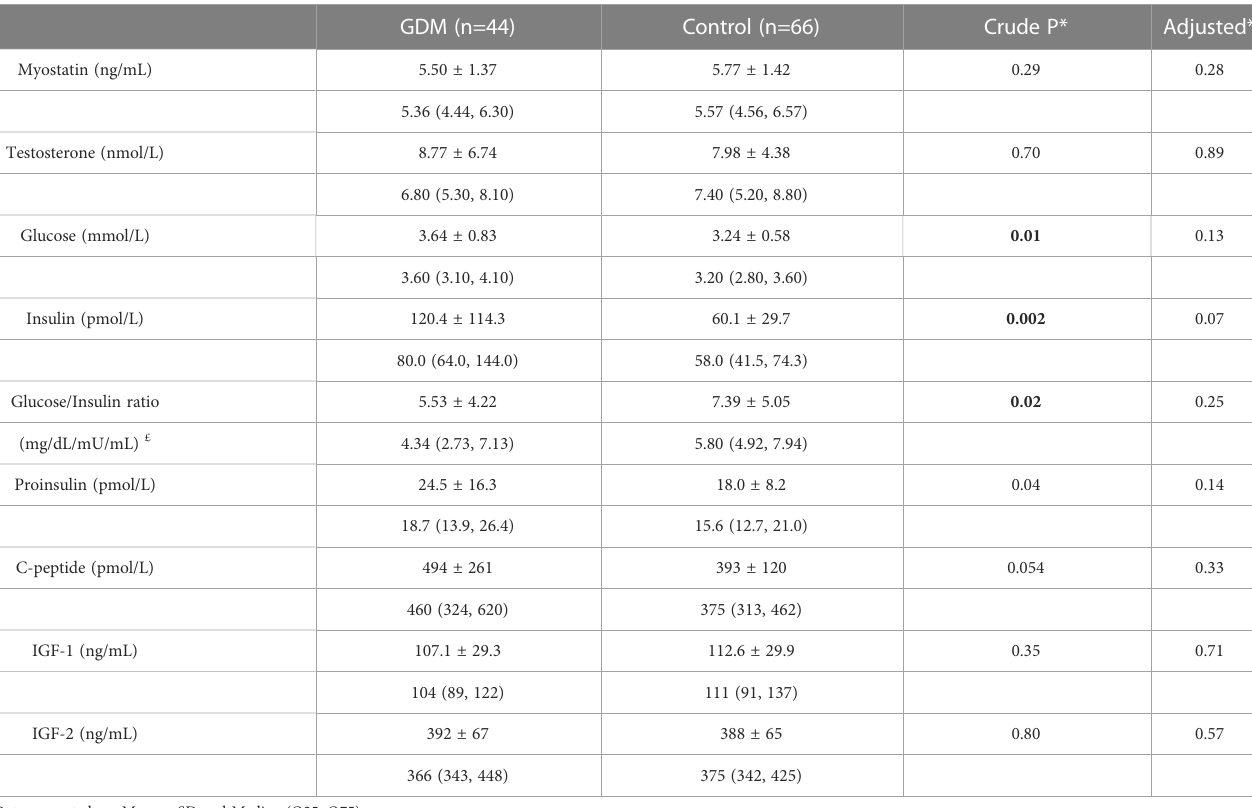
TABLE 4 Cord blood concentrations of myostatin, testosterone and fetal growth factors comparing GDM vs . euglycemic